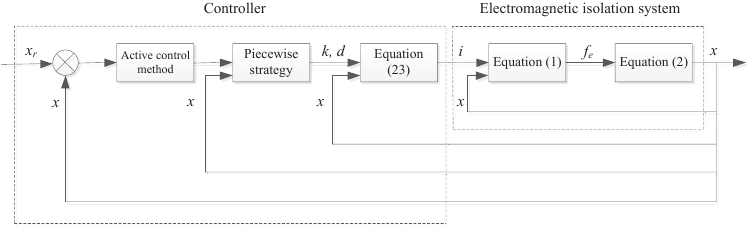
Figure 7. The control diagram with the piecewise